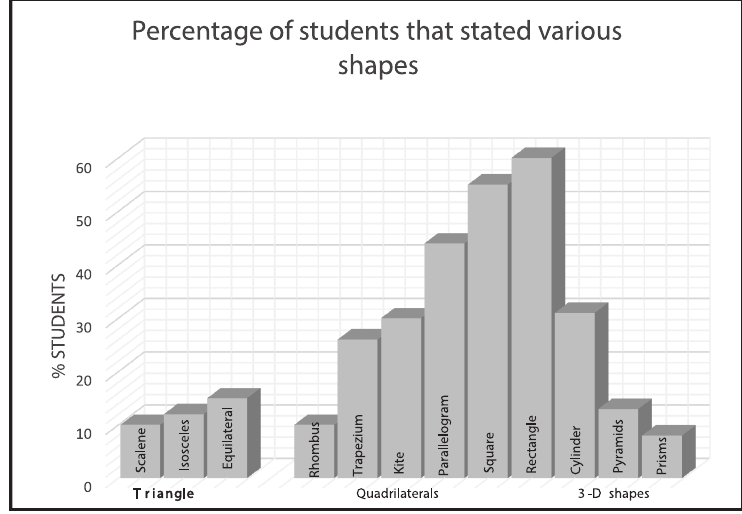
Figure 4: Percentage of students who were able to name each shape in the